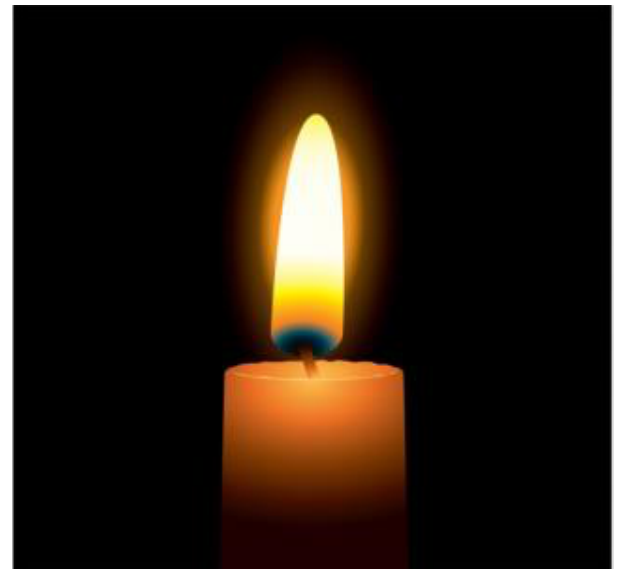
Figure 2. The Candle Flame Is A Common Dissipative